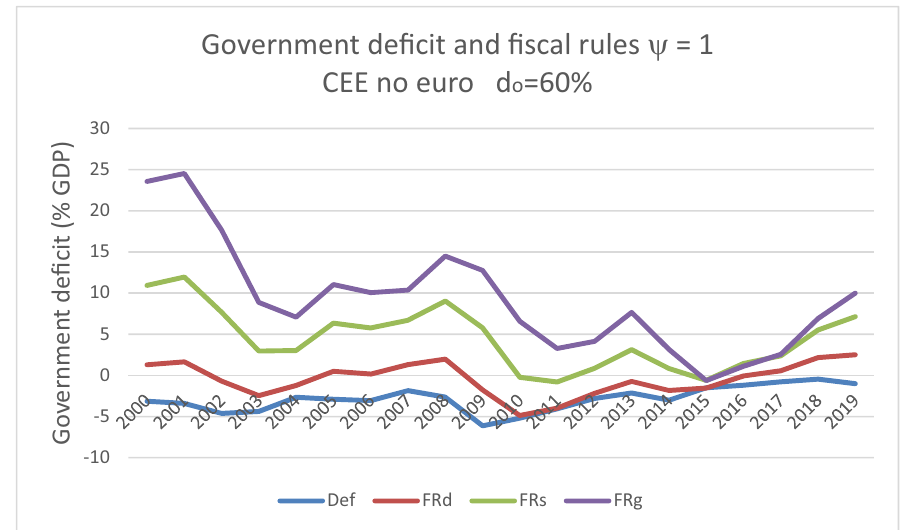
Figure 1.7: CEE no € countries government de fi cit ψ = 1 ( Source: Own elaboration from data on Table 1 )